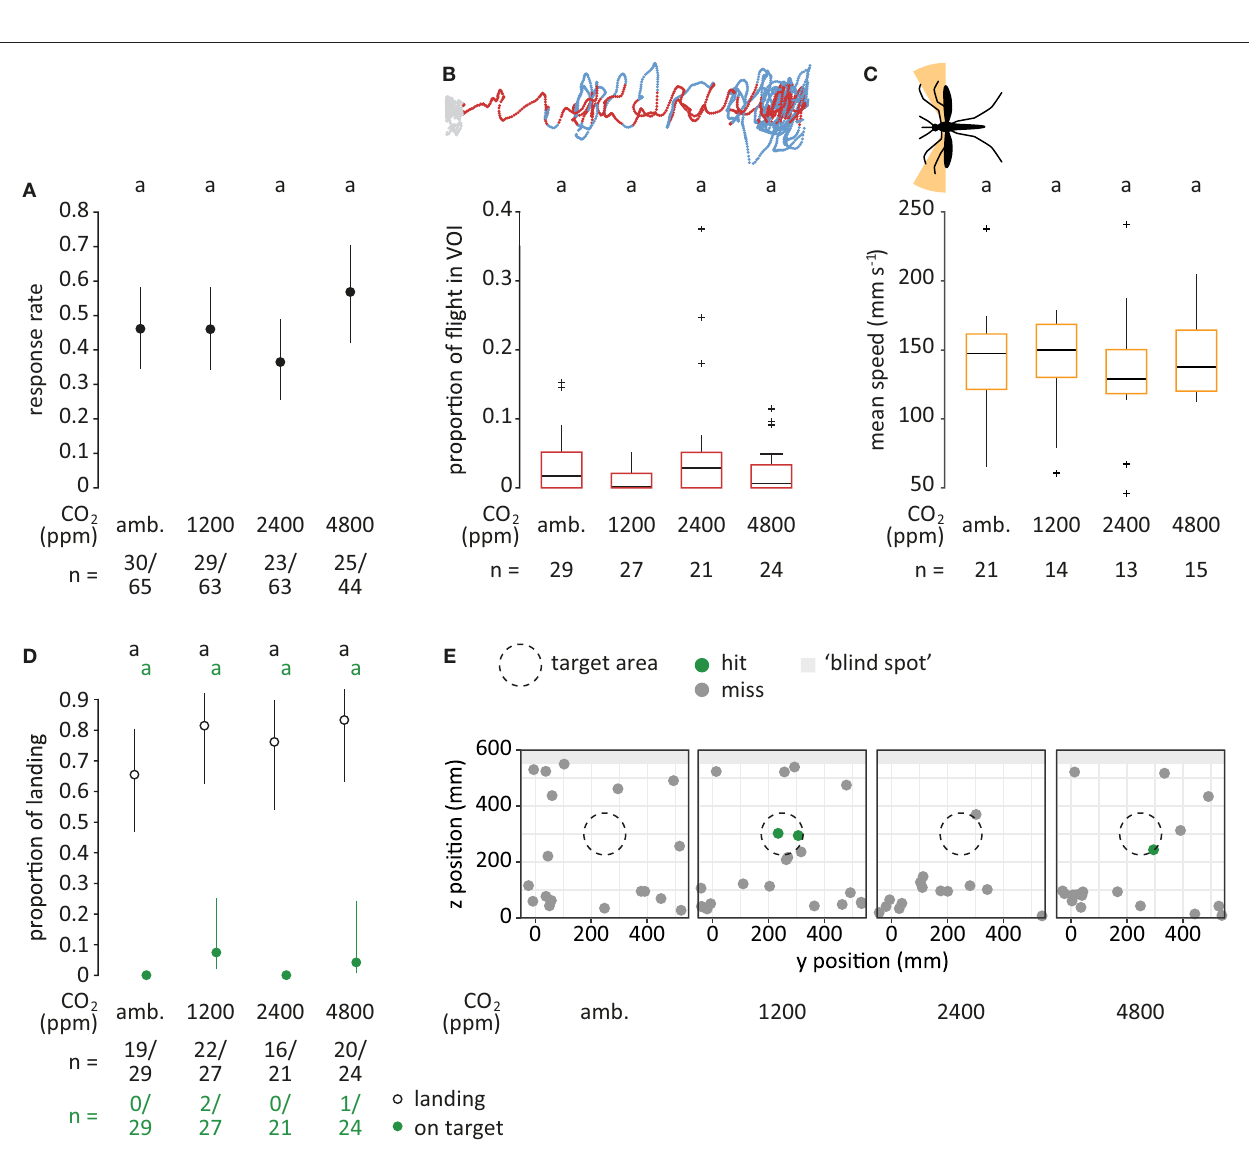
foot odor, and their interaction, contributed significantly to